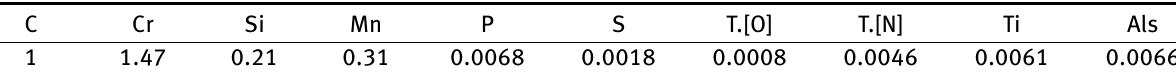
Table 1: Chemistry composition of raw material pieces, wt%.